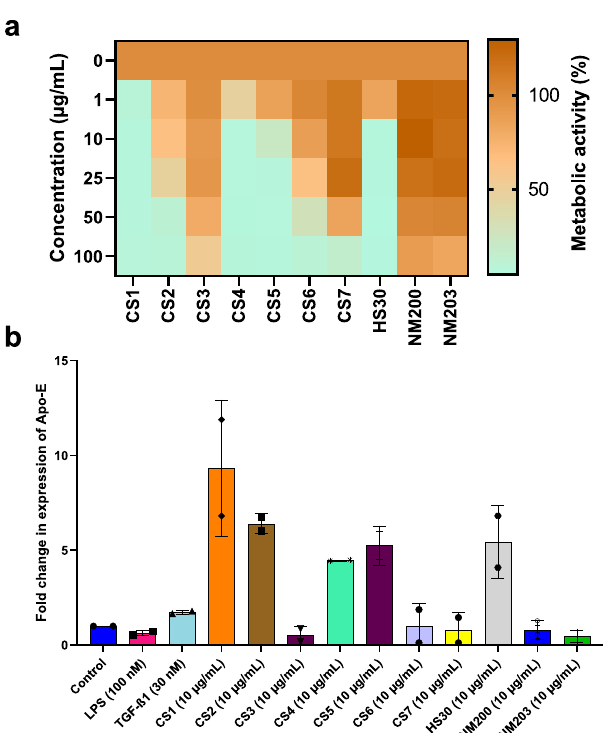
Fig. 5 Molecular marker validation using the THP-1 model. Effect of a panel of silica ENMs on cell viability and expression of the APOE gene in THP-1 cells. a Heatmap showing changes in metabolic activity (corresponding to cell viability) of cells after 24 h of exposure to SiO2 ENMs. b Fold change in the expression of APOE mRNA at 24 h of exposure to 10 µ g/mL. LPS (100 nM) and TGF- β (30 nM) were used as a reference. Data represent mean values ± SD ( n = 2 independent experiments each performed in